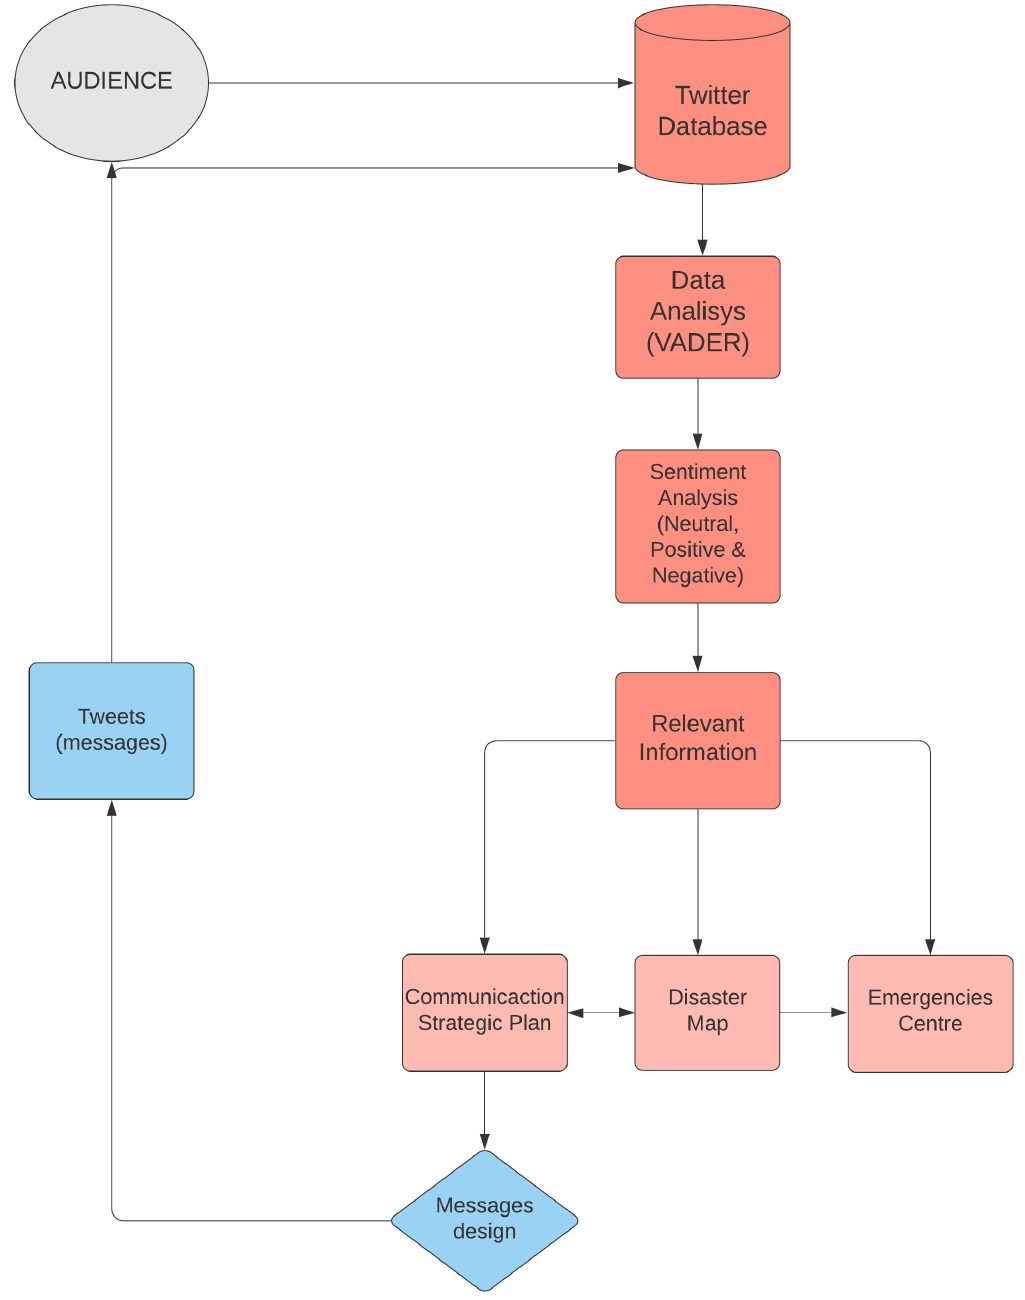
Figure 4. Flowchart. Source: own elaboration.